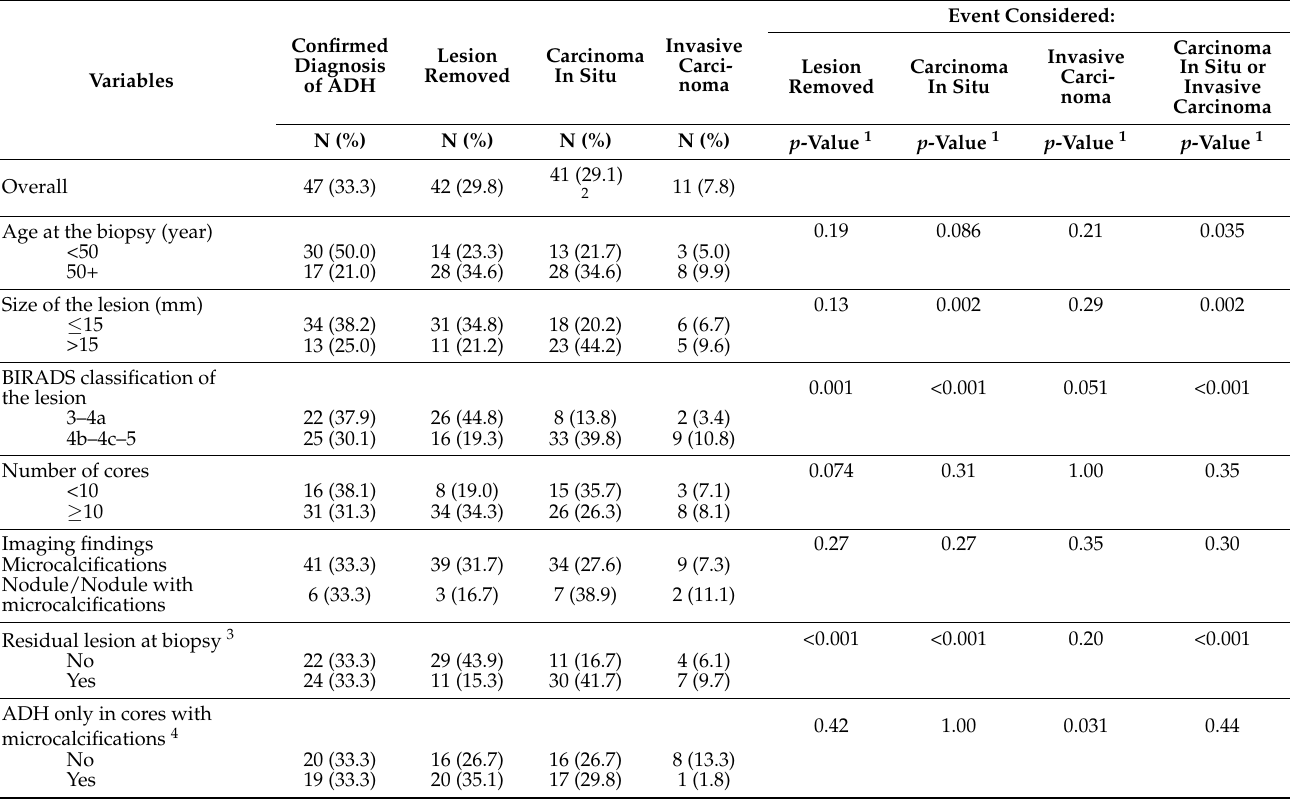
Table 2. Association between patients’ characteristics and four outcomes (univariate analysis).